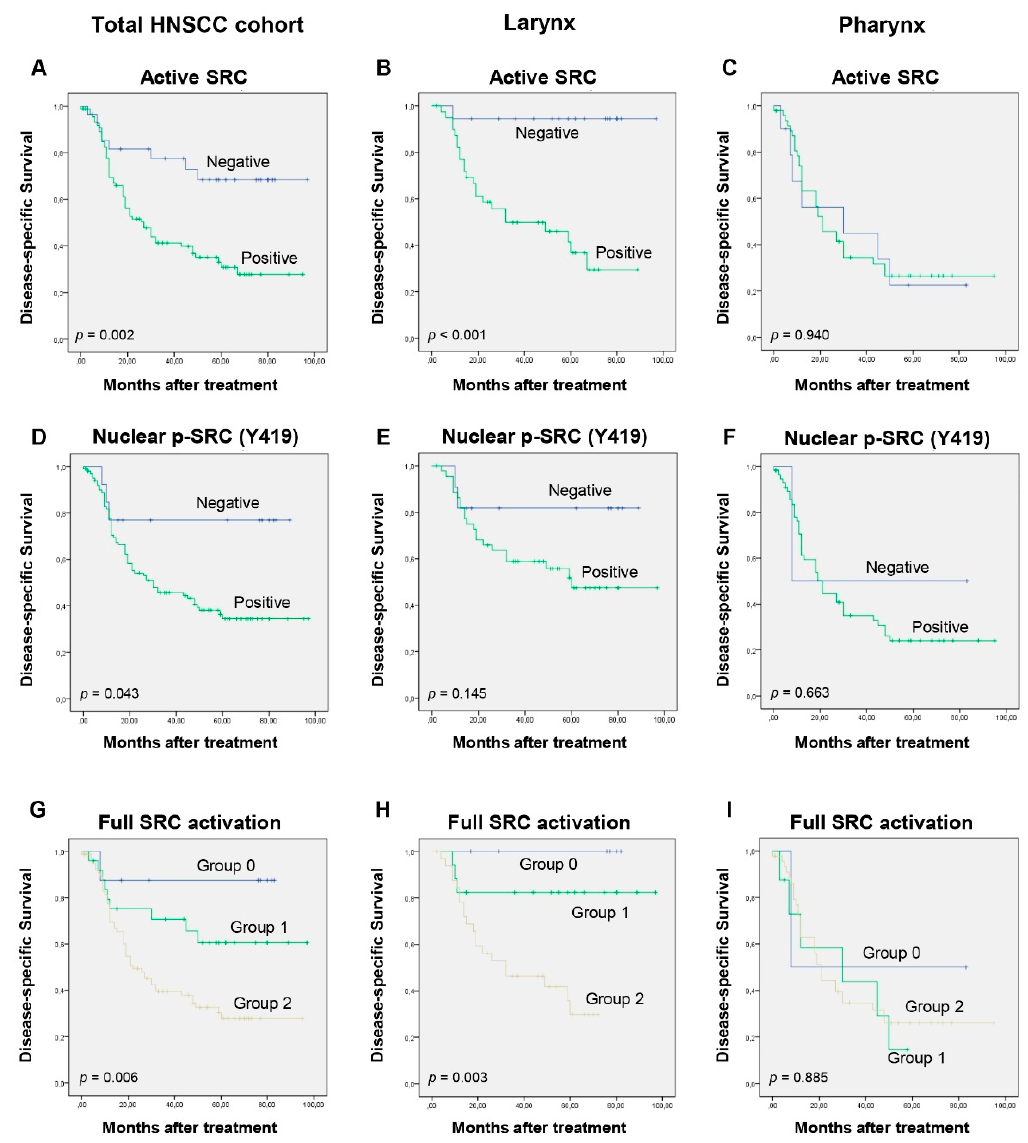
Figure 2. Impact of SRC expression on patient survival. Kaplan–Meier disease-specific survival curves